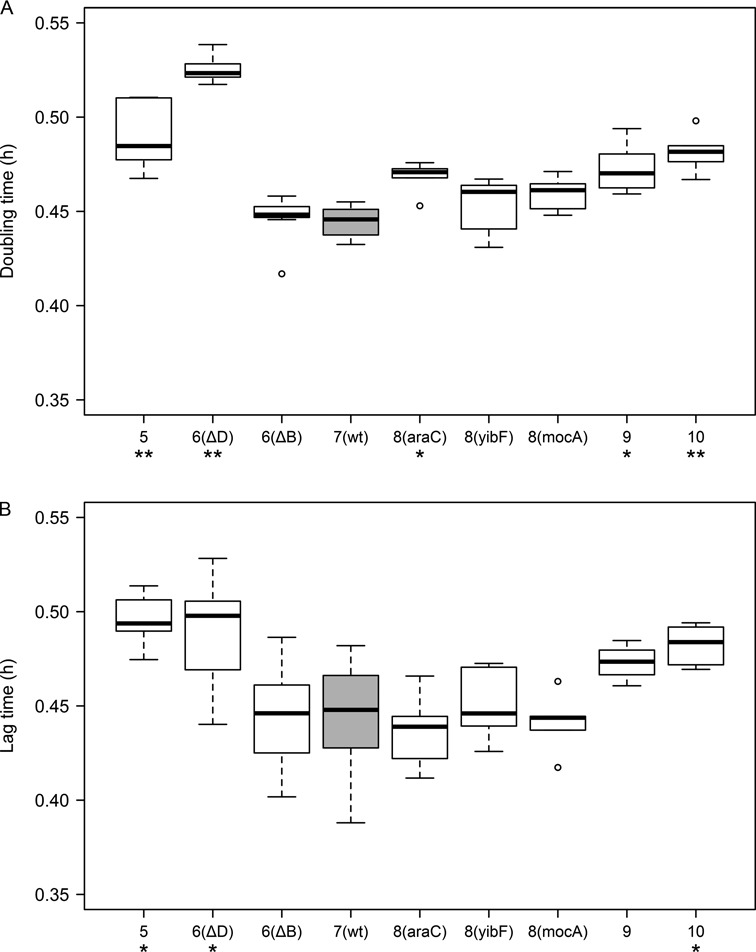
Growth parameters of the strains grown in rich (LB) medium. Doubling time (A) and lag time (B) of cells are shown (at least 5 biological replicates per strain with 40 technical replicates each). Center lines show the medians; box limits indicate the 25th and 75th percentiles; whiskers extend 1.5 times the interquartile range; and outliers are represented by circles. Asterisks show significant difference compared to the wt (*P < 0.05, **P < 0.001; one-way ANOVA with post hoc Dunnett's test).